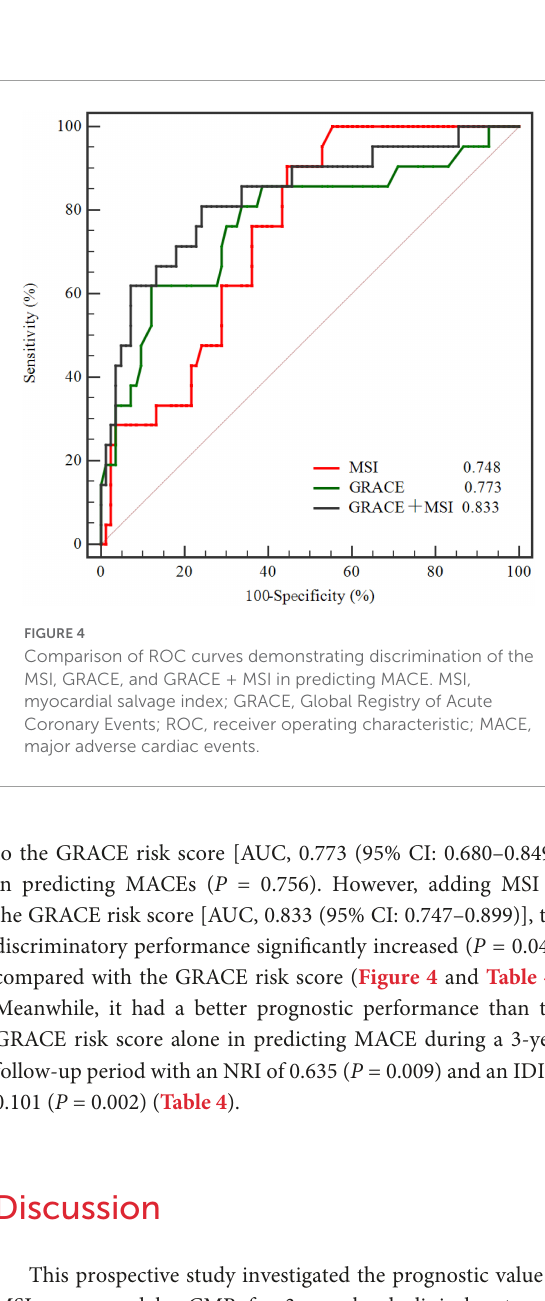
to the GRACE risk score [AUC, 0.773 (95% CI: 0.680–0.849)] in predicting MACEs ( P = 0.756). However, adding MSI to the GRACE risk score [AUC, 0.833 (95% CI: 0.747–0.899)], the discriminatory performance significantly increased ( P = 0.044) compared with the GRACE risk score ( Figure 4 and Table 4 ).